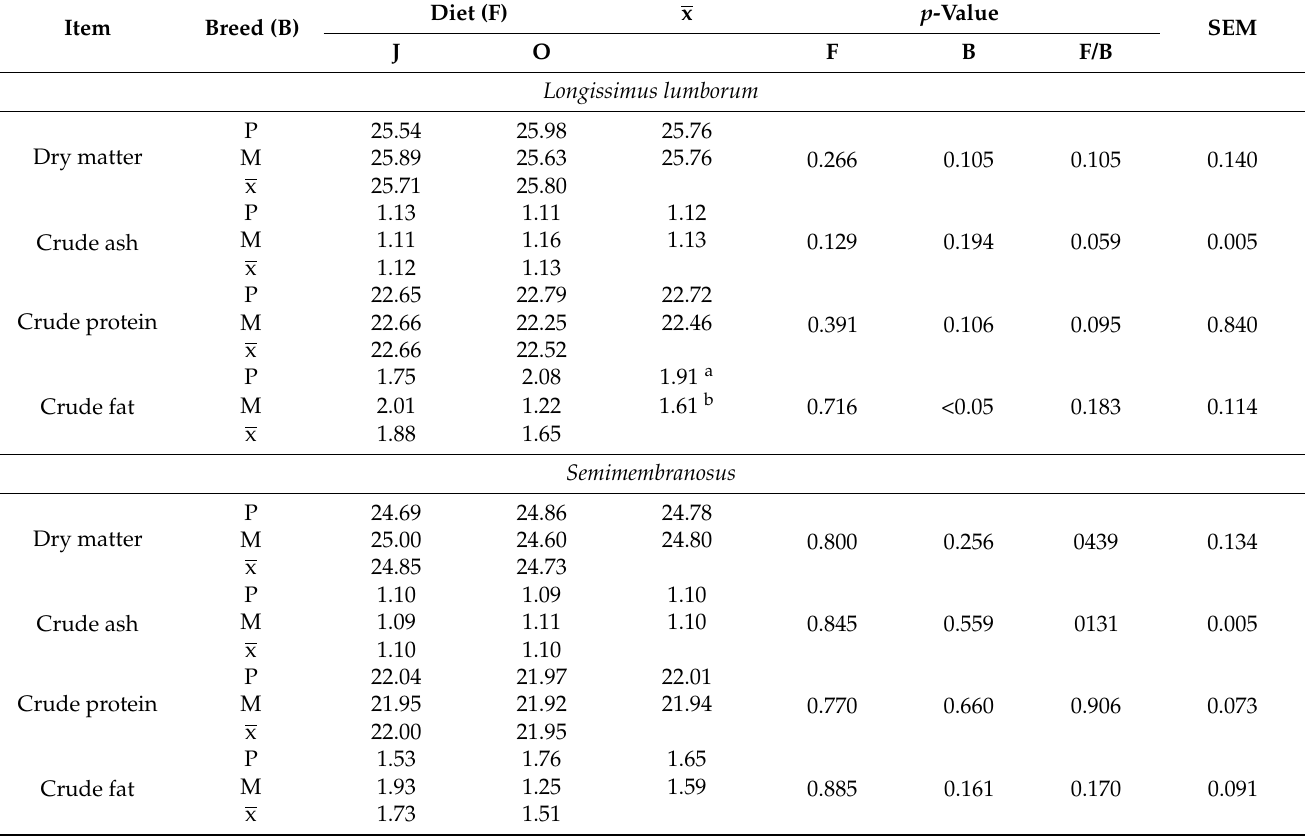
Table 6. Chemical composition (g/100 g) of